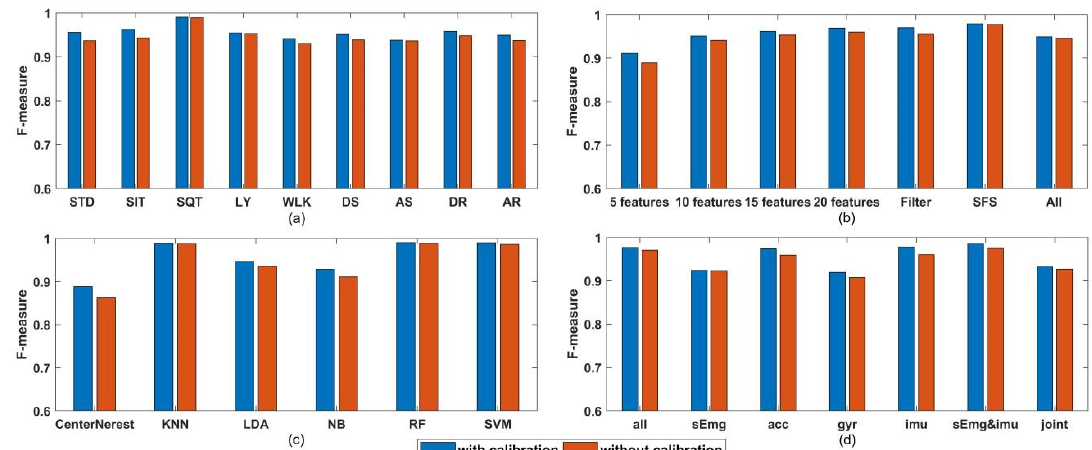
Figure 8. ( a ) F-measure per activity for dataset with calibration and without calibration. ( b ) F-measure per feature subset for dataset with calibration and without calibration. ( c ) F-measure per classification algorithm for dataset with calibration and without calibration. ( d ) F-measure per sensor combination for dataset with calibration and without calibration. Figure 8c revealed that among all the classification algorithm used in this work, KNN, Random Forest and SVM end up with the best performance (their FM are 0.982, 0.982 and 0.976, respectively), which is similar with the result in [17]. Therefore, to simplify the